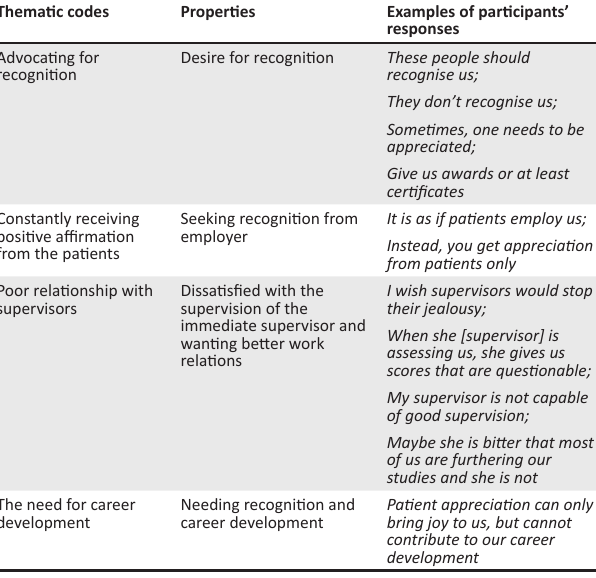
TABLE 6: Thematic codes for focus group response to lack of recognition and appreciation for their work.